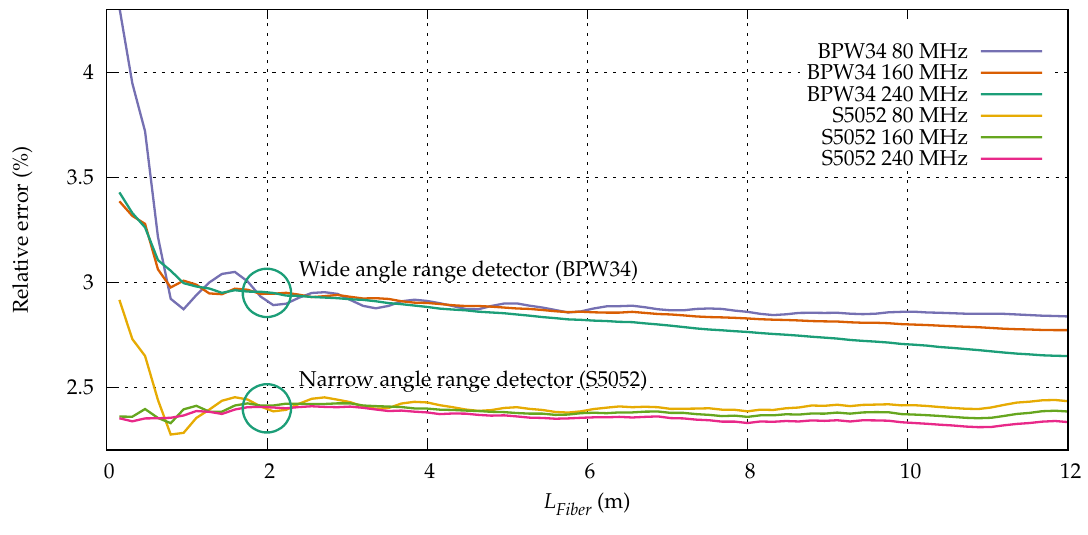
Figure 17. Relative error of the fiber length obtained from the measured phase.